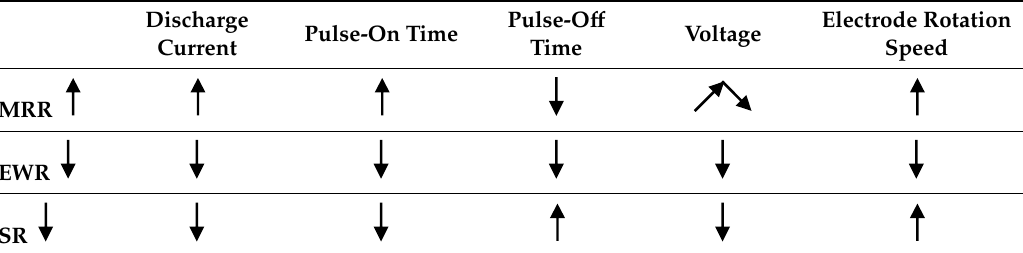
Table 4. General effect of major operating parameters on key performance measures.